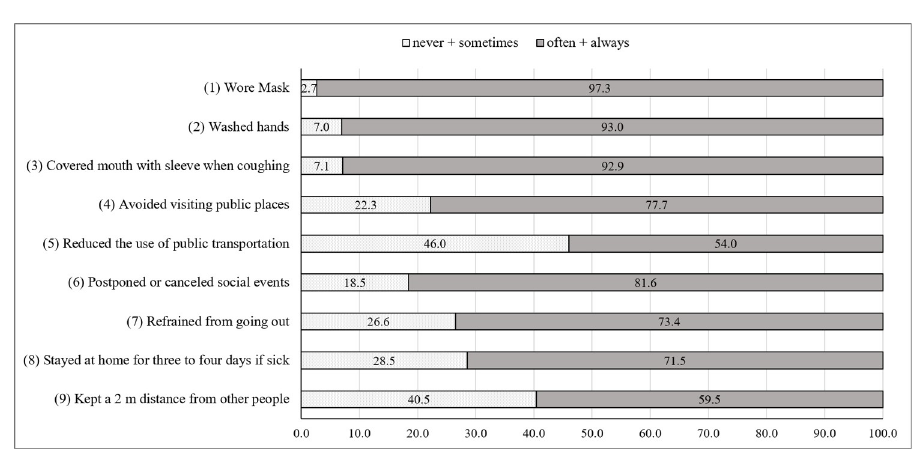
Fig 1. Frequency of protective behaviors against